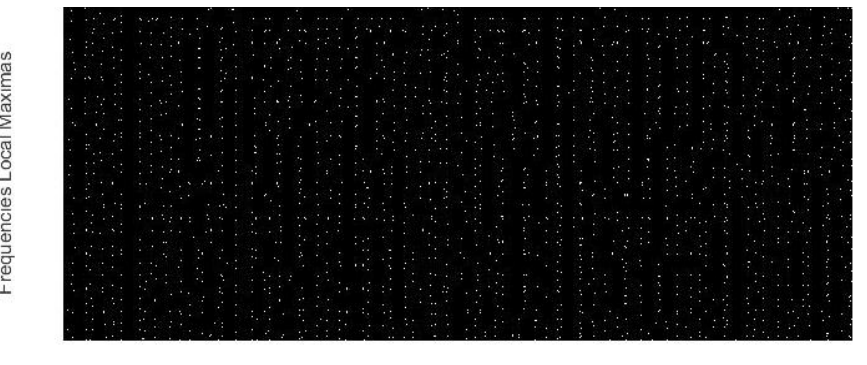
Fig. 2. Frequency’s local maxima of a